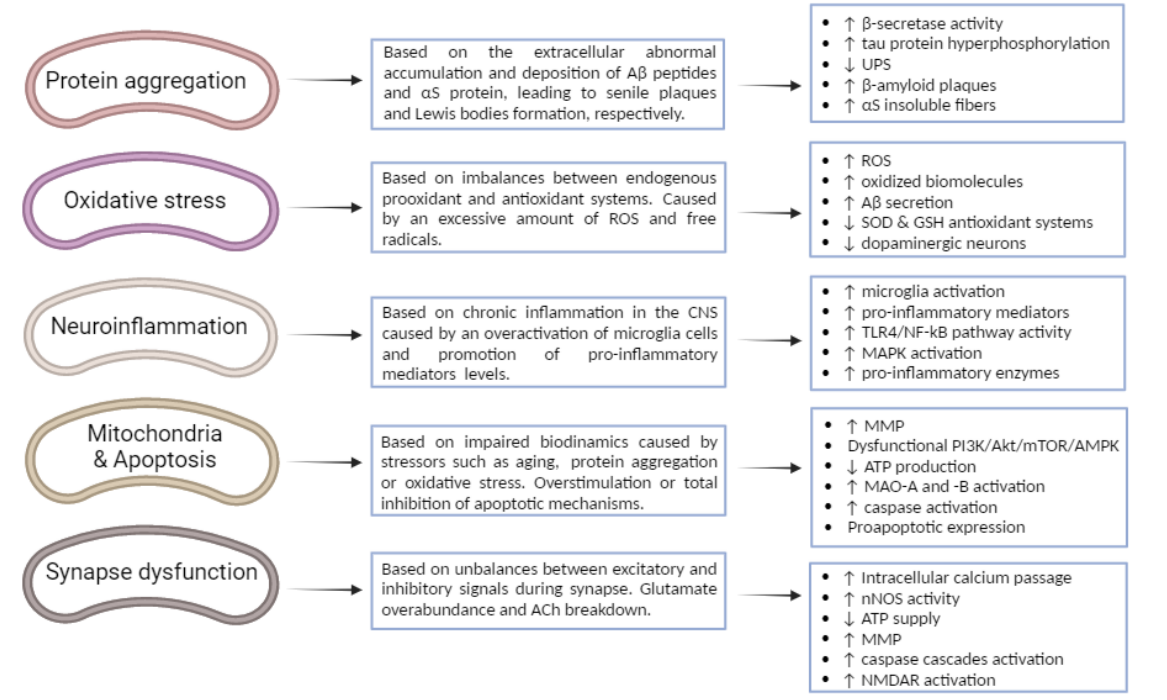
Figure 2. Different key biological mechanisms associated with the neurodegeneration implicated in the progression and pathogenesis of AD and PD, as well as the main cellular processes involved. ↑ : increase; ↓ : decrease.